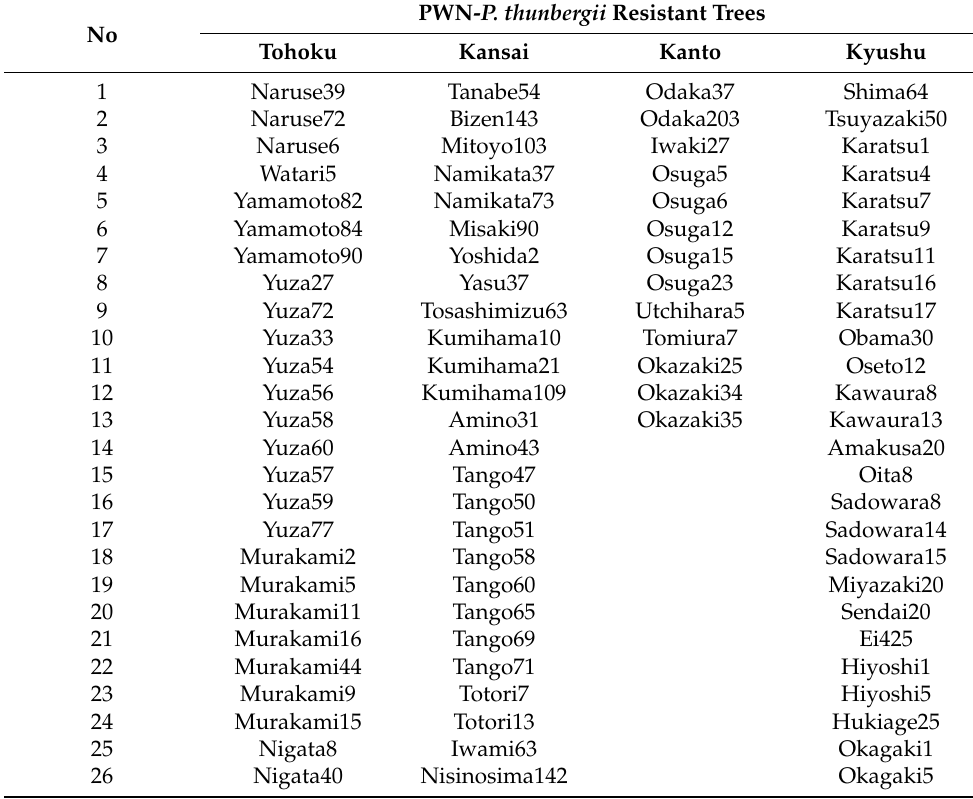
Table A2. List of PWN- P. thunbergii resistant trees based on the region